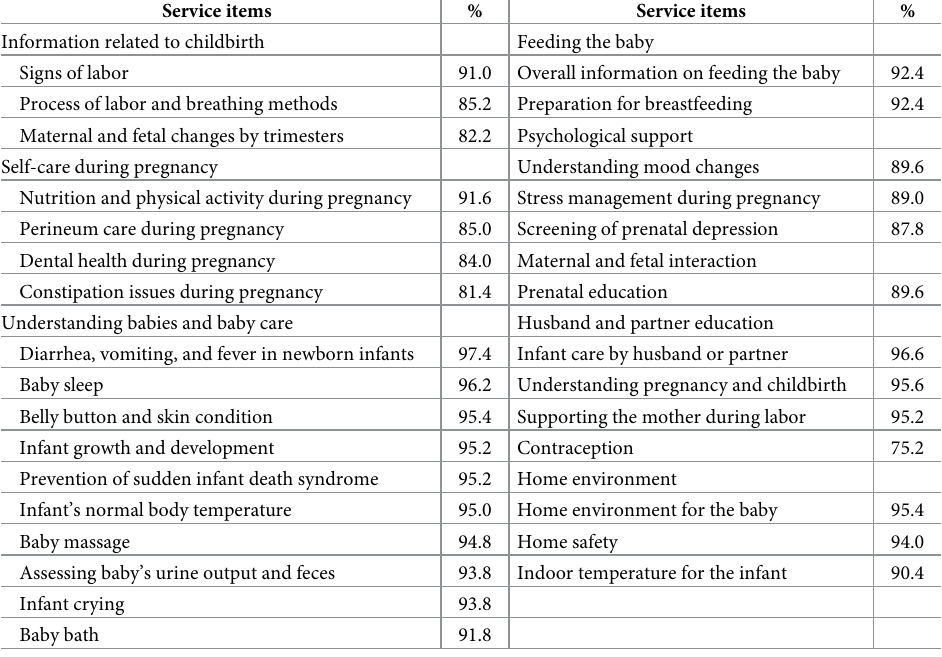
Table 4. Needs (%) for prenatal nurse home visitation services among pregnant women and women with children below the age of 24 months (N = 500). Service